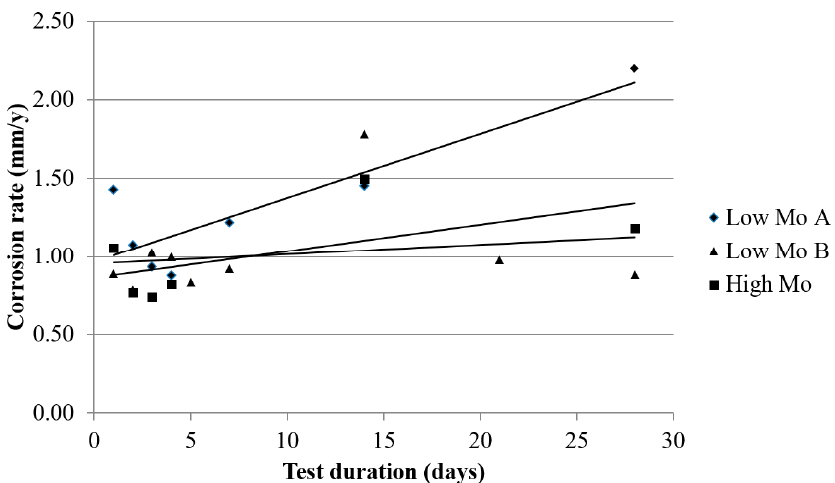
Figure 10. The corrosion rate of the low Mo (A), the low Mo (B), and the high Mo materials as a function of the test duration.